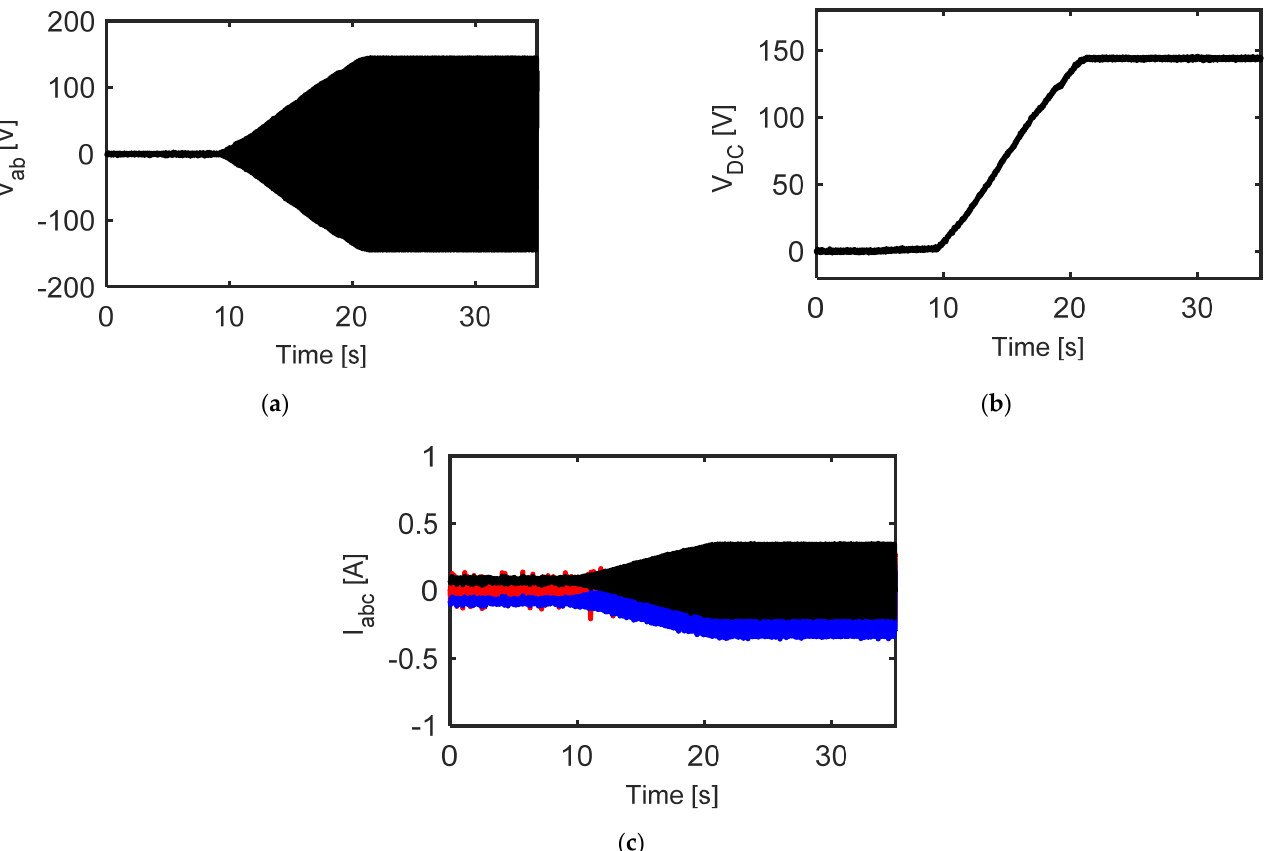
Figure 8. Simulation testing of the clamping circuit at start-up without operating the PWM of the rectifier and charging using line voltage V ab at zero crossing ( a ) Line-input voltage V ab , ( b ) DC-link voltage and ( c ) input current for MC.